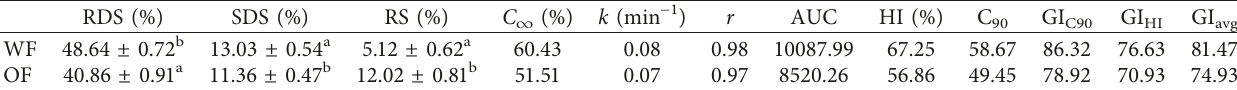
Table 4: Digestibility and glycemic parameters of nonlinear kinetic model of wheat flour and optimized flour 1 . RDS (%) SDS (%) RS